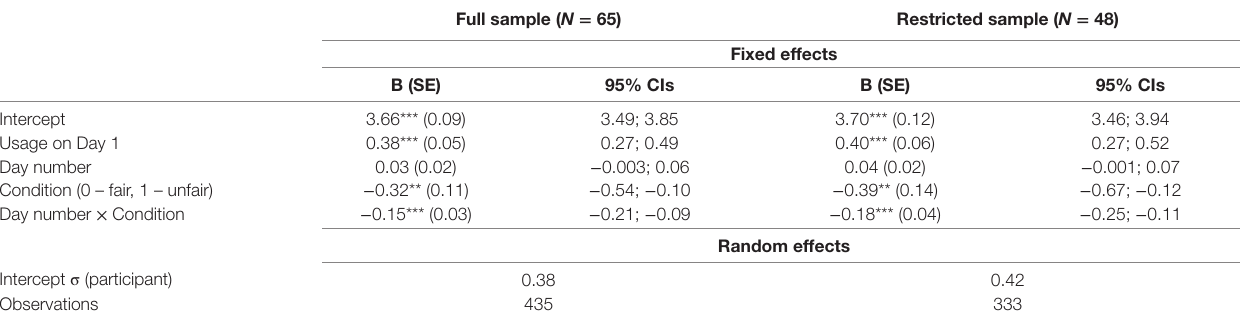
TaBle 3 | Model 1: mixed-effects random intercept regression model predicting the usage on day i